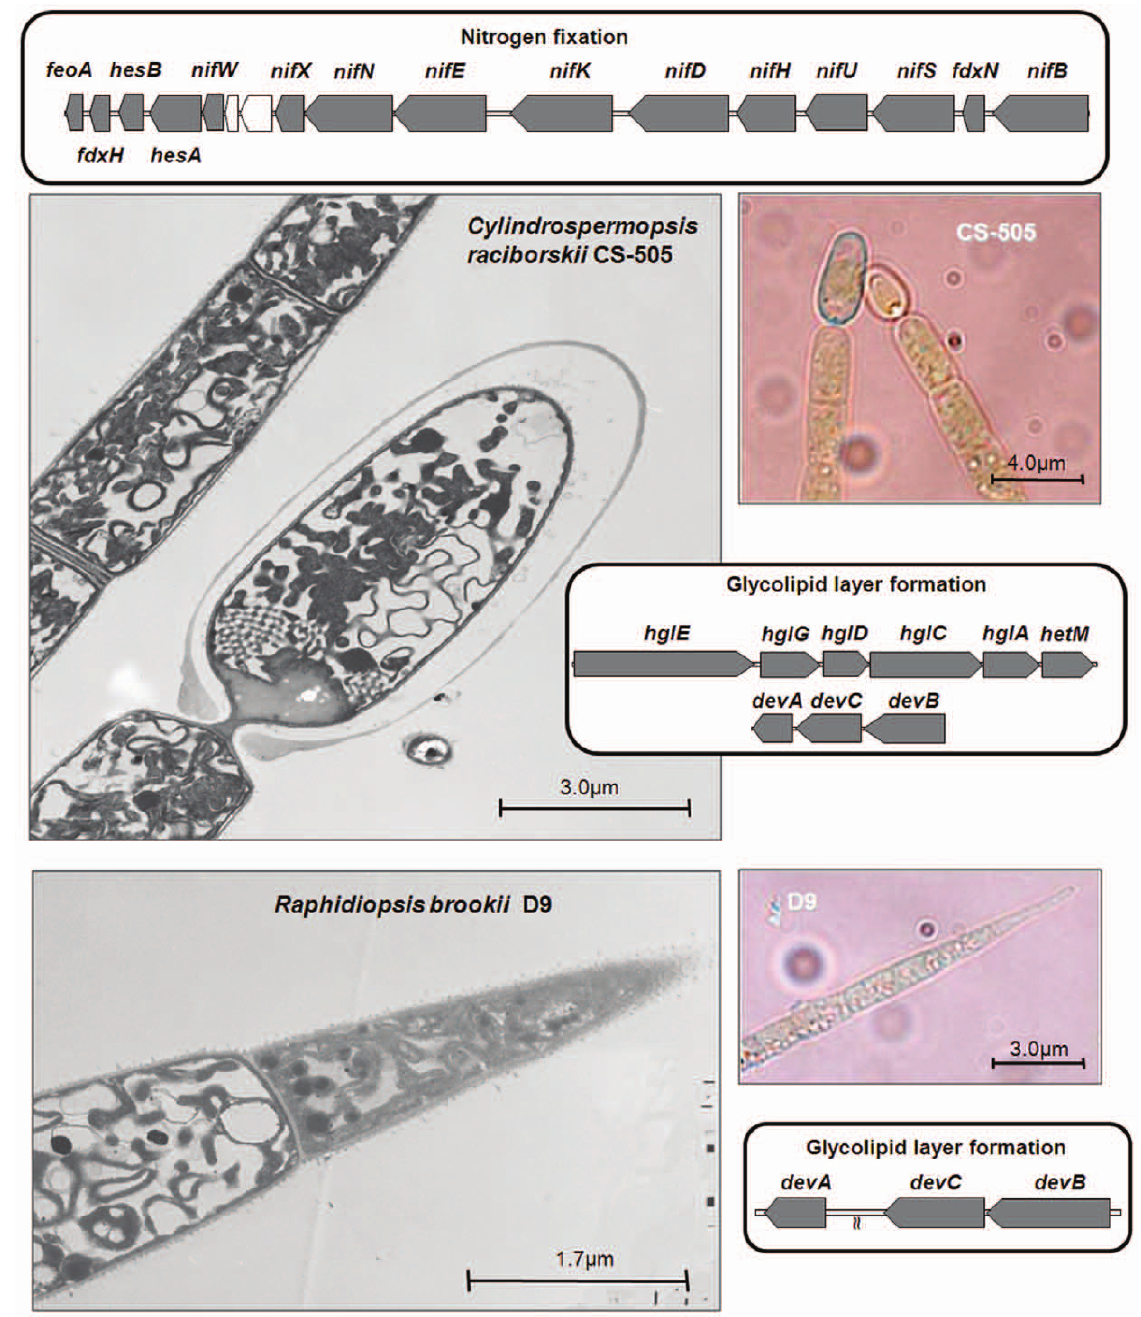
Figure 1. Overview of the main gene clusters involved in nitrogen metabolism and heterocyst development in strains CS-505 and D9. Transmission electron micrographs in the left panels show the heterocyst of CS-505 and the apically differentiated cell of D9. Optical micrographs on the right panels exhibit the Alcian blue staining characteristic of polysaccharides in the heterocyst.